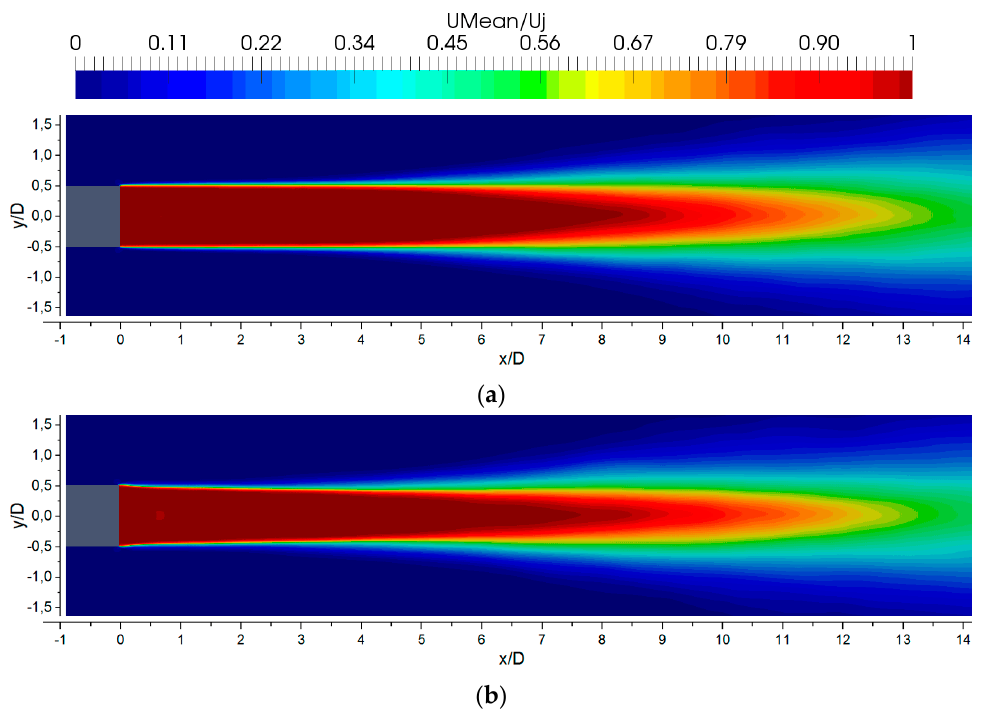
Figure 6. Mean velocity field: ( a ) normal jet; ( b ) with water injections.